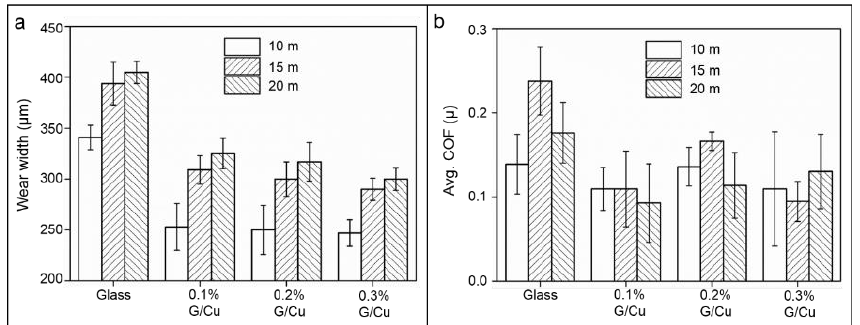
Figure 7. ( a ) Wear width and ( b ) average friction coefficient of NGCC.